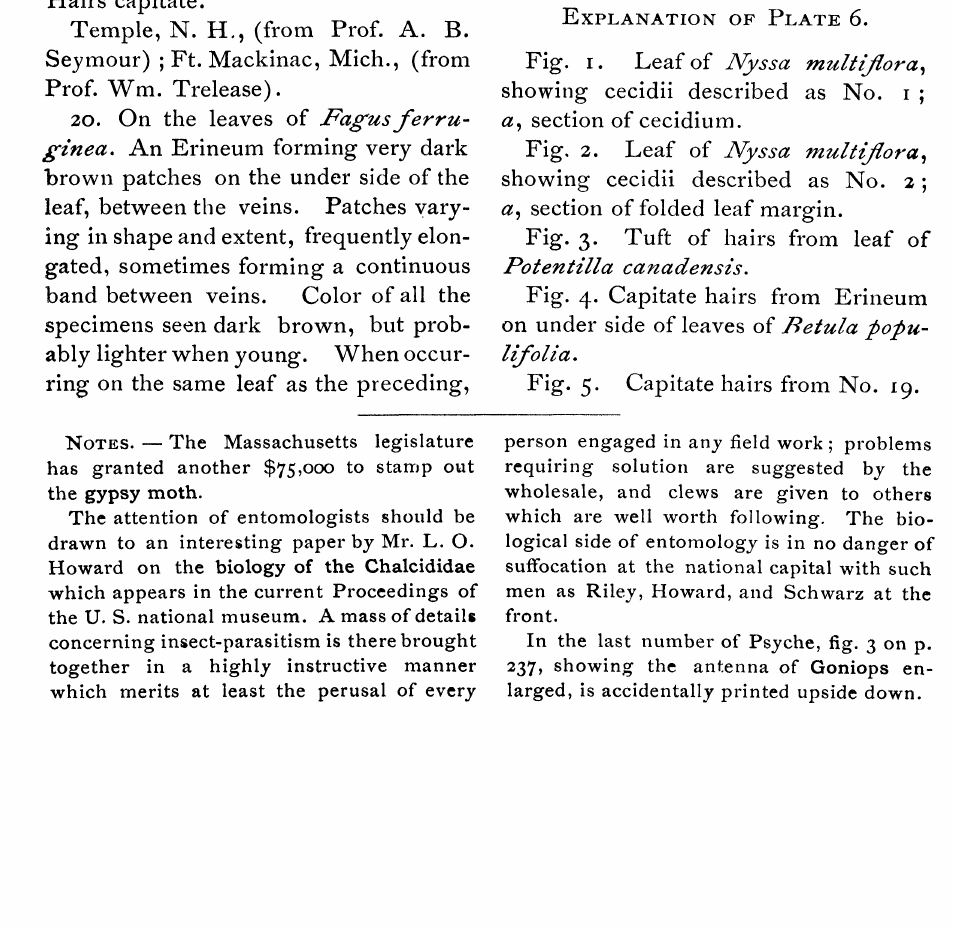
. Leaf of 2Vyssa multiora, Fig. showing cecidii described as No. i; a, section of cecidium. Fig. 2. Leaf of JVyssa multijqora, showing cecidii described as No. 2; a, section of folded leaf margin. Fig. 3. Tuft of hairs from leaf of Potentilla canadensis. Fig. 4" Capitate hairs from Erineum on under side of leaves of ]?etula popu- lifolia. Fig. 5;. Capitate hairs from No.